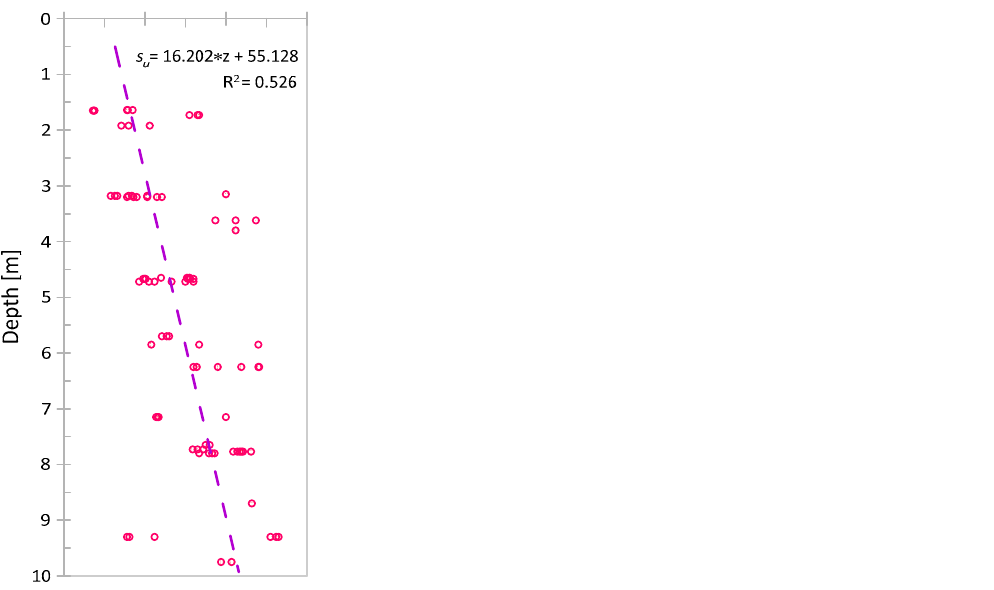
Figure 7. Results of s u for Keswick clay with depth based on Appendix C of the PhD thesis by [43] together with the obtained linear trend.